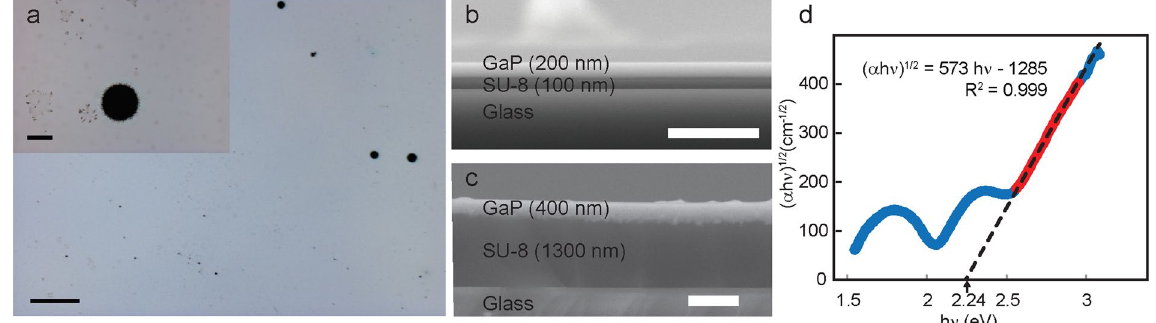
Figure 3. Micrographs and transmission spectrum of substrate removed GaP film. ( a ) Optical micrograph showing some typical defects in the films. The scale bar is 200 μ m in the large image and 20 μ m in the inset. ( b ) Cross sectional scanning electron microscope image of a thin (200 nm) GaP film bonded to glass with a thin interlayer. This particular film did not have metal contacts, and as a result, the interlayer was only 100 nm thick. The scale bar is 1 μ m. ( c ) Cross sectional scanning electron microscope image of a thick (400 nm) GaP film bonded to glass with a thick interlayer (1300 nm), determined by the thickness of the metal contacts. The scale bar is 1 μ m. ( d ) Tauc plot generated from normal incidence transmission measurements of a substrate removed GaP film. A linear fit was generated from the red data points with bounds selected to maintain R = 0.999, and the fit indicates a bandgap of 2.24 eV.